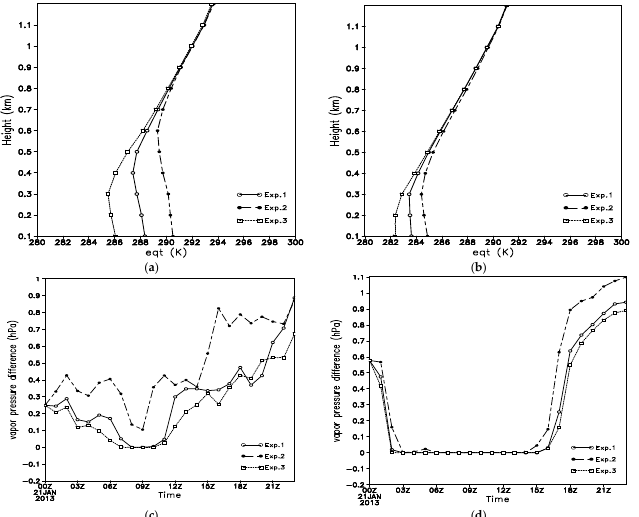
Figure 8. Vertical profiles of the regional mean pseudo-equivalent temperature for the control and sensitivity experiments (units: K) at 08 UTC on 21 January 2013 in ( a ) central and ( b ) northern Yellow Sea; regional average time series of water vapor pressure and saturation water vapor pressure dif- ference (e-es) (units: hPa) for control and sensitivity experiments in ( c ) central and ( d ) northern Yellow Sea. For the central Yellow Sea region, the variation in relative humidity was more af- fected by advection and radiation effects. The dissipation of the sea fog with increasing SST in the lower layer was related to the negative advection effect in the U-direction (Fig- ure 7a) and the reduced stability (Figure 8a), which caused an increase in the height for the top of the inversion layer. The turbulent humidifying effect decreased with increasing SST below a height of 300 m. These factors were not conducive to water vapor accumula- tion in the central Yellow Sea region. Lee et al. [37] also found that strong turbulent mixing increases the boundary layer height, which contributes to the rapid growth of the height of sea fog. As a result, the main reasons for the opposite change in sea fog induced by the SST variation were the advection effect in the U-direction, the turbulence effect in the lower layer, and the stability related to the height of the inversion layer.